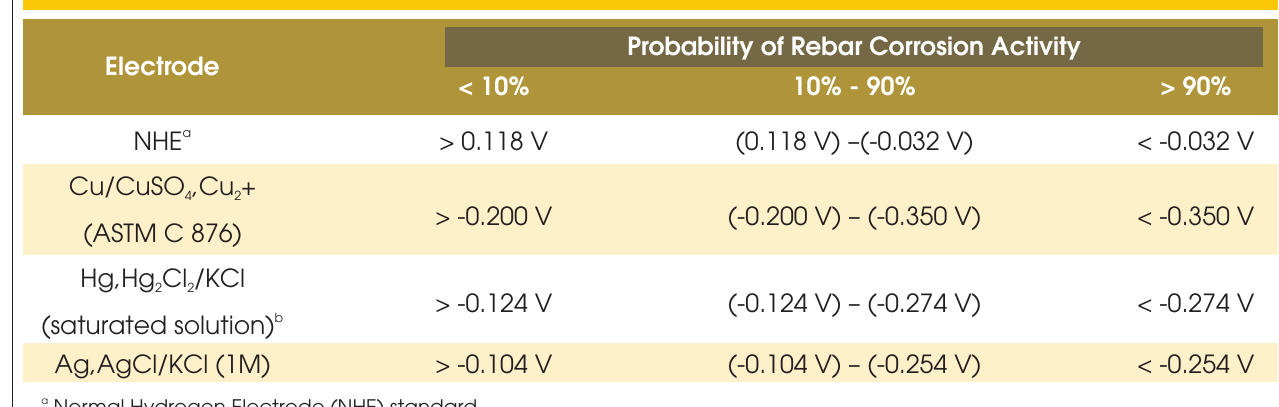
Table 1 – Probability of rebar corrosion activity as a function of ranges of corrosion potential of various reference electrodes in accordance with the ASTM C-876/91 standard